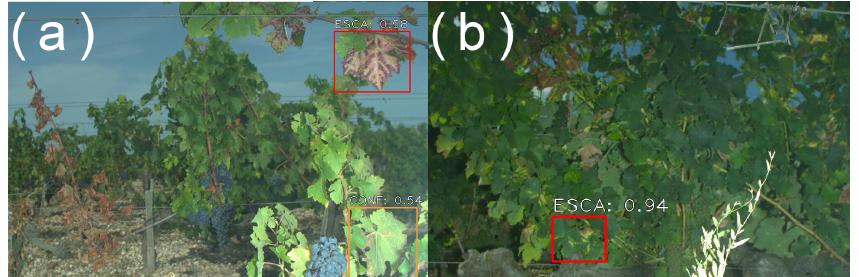
Figure 12. Example of detection results from the ADVANTAGE esca disease dataset. Red boxes: esca detections. Orange boxes: other symptoms and deficiencies detections. ( a ) Example of good behavior: background-row dried leaves appropriately not detected. ( b ) Example of bad behavior: background-row esca leaf detected. Figures in both images indicate the algorithm’s